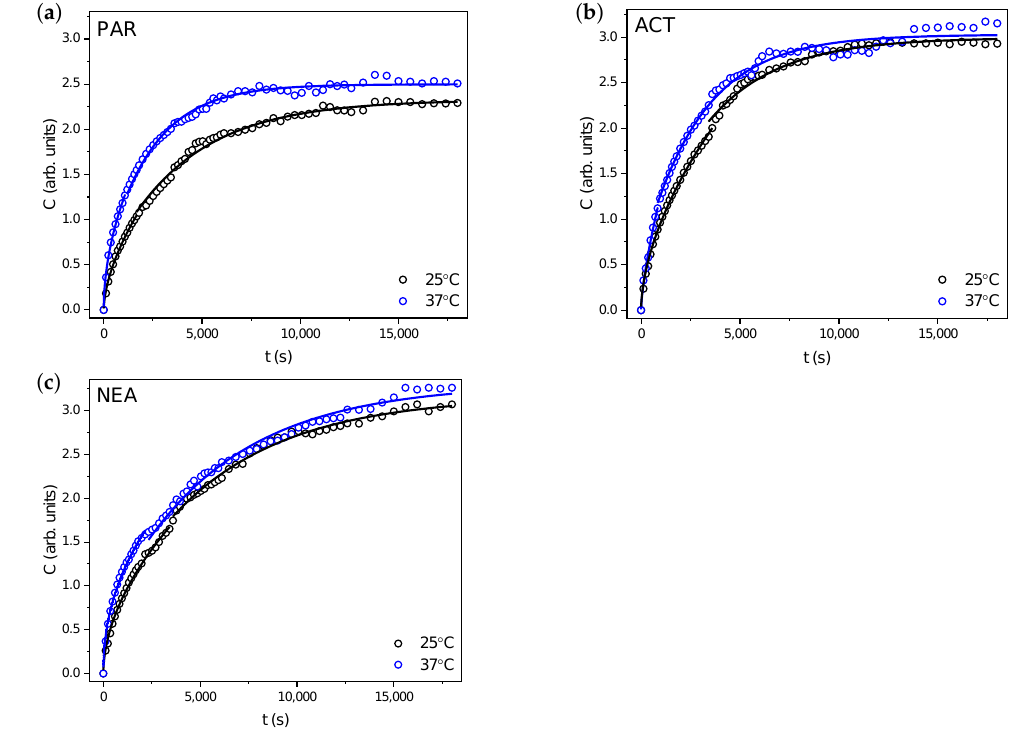
Figure 7. Changes in molar concentration ( C ) of ( a ) PAR, ( b ) ACT, and ( c ) NEA released from PU/PEG hydrogels at 25 ◦ C (black circles) and at 37 ◦ C (blue circles). The solid lines represent the fitted theoretical models. Table 5. The values of parameters describing the release process for studied hydrogel systems obtained by fitting Equa- tions (15) and (16) (Korsmeyer–Peppas and Hopfenberg models) to two stages of release.